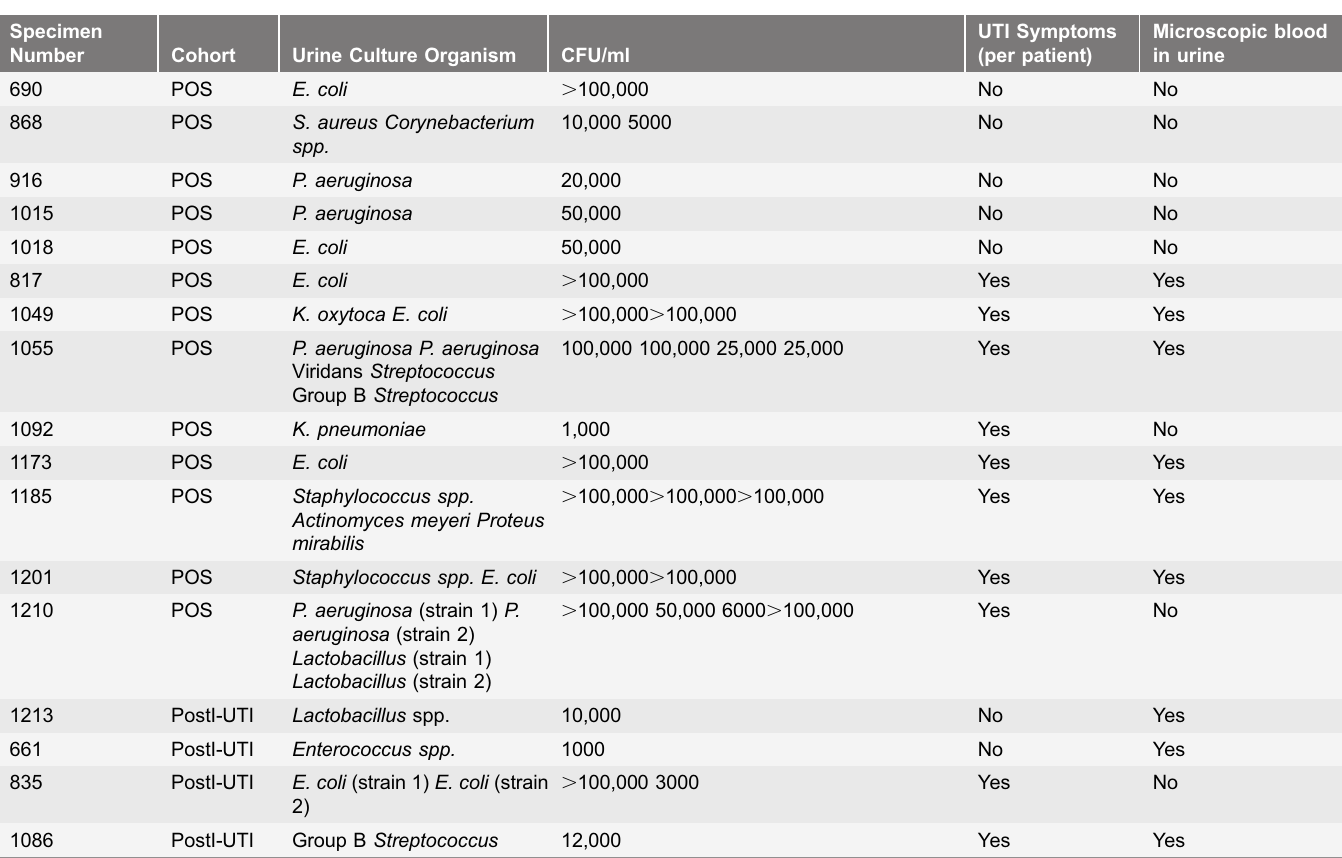
Table 2. Culture results from POS and PostI-UTI cohorts. Specimen